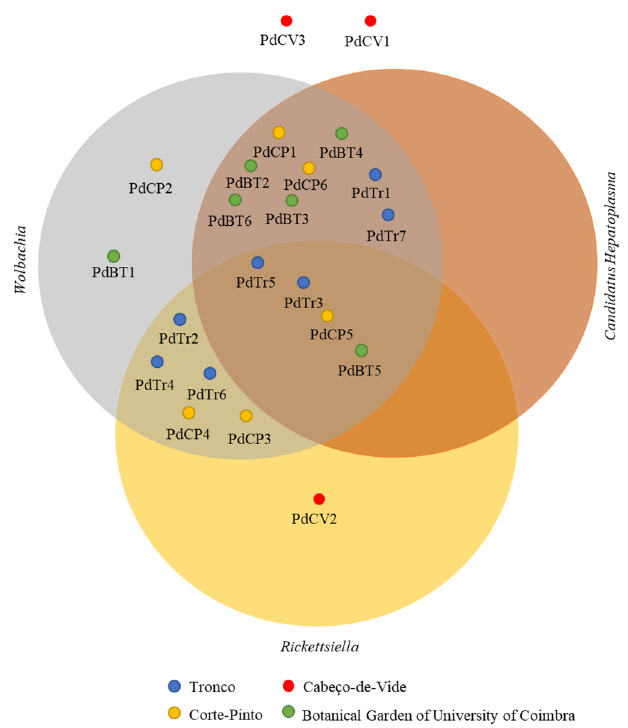
Figure 5. Three-way Venn diagram showing Porcellio dilatatus guts infected by Wolbachia (grey), Rickettsiella (yellow) and Candidatus Hepatoplasma (orange). P. dilatatus guts were sampled from Tronco (PdTr); Corte Pinto (PdCP); Cabeço-de-Vide (PdCV) and Botanical Garden of University of Coimbra (PdBT).